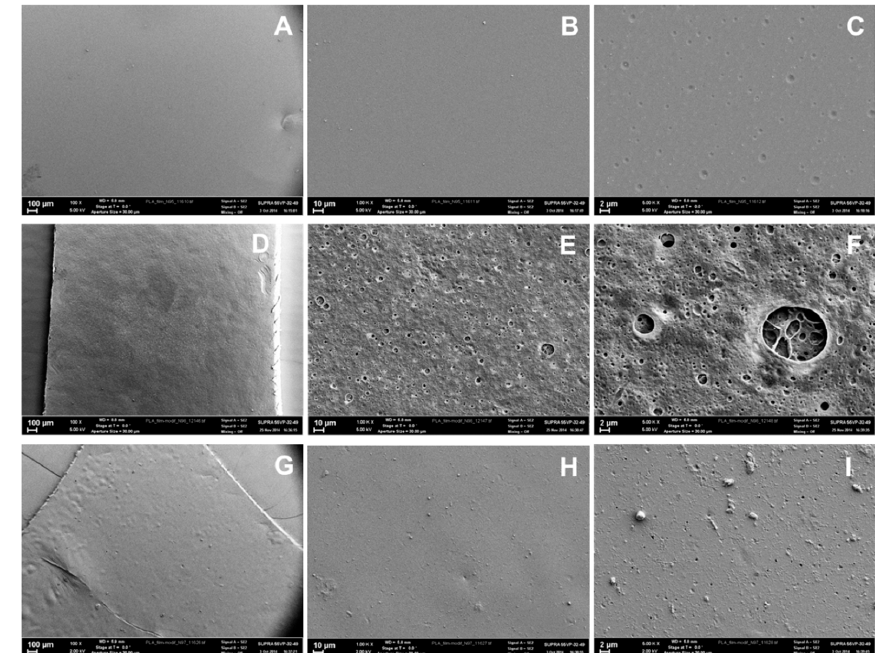
Figure 8. SEM images of the initial and modified surface of the PLA films: ( A – C ) initial PLA film; ( D – F ) PLA-PAAm; ( G – I ) PLA-Alg. The magnification of images in the series is 100×, 1000× and 5000×, correspondingly.